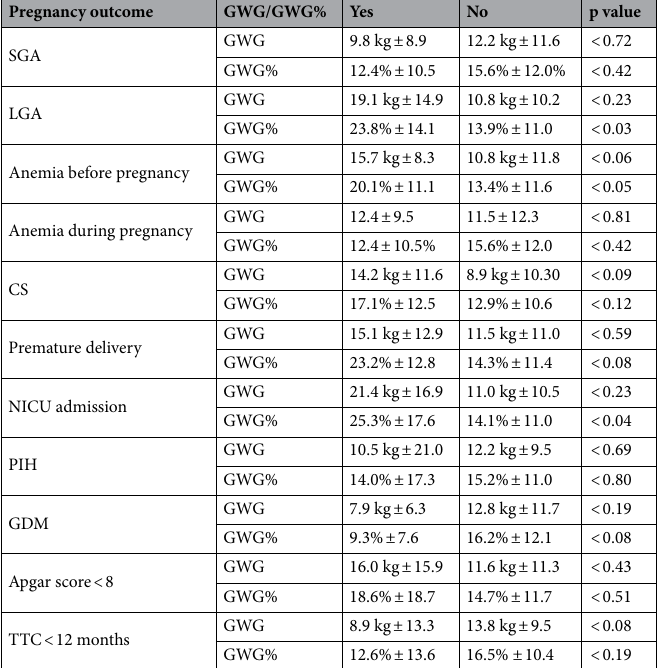
Table 2. GWG, GWG% and pregnancy outcomes. SGA small for gestational age infants, LGA large for gestational age infants, CS cesarean section, NICU neonatal intensive care unit, PIH pregnancy induced hypertension, GDM gestational diabetes mellitus, TTC time from surgery to